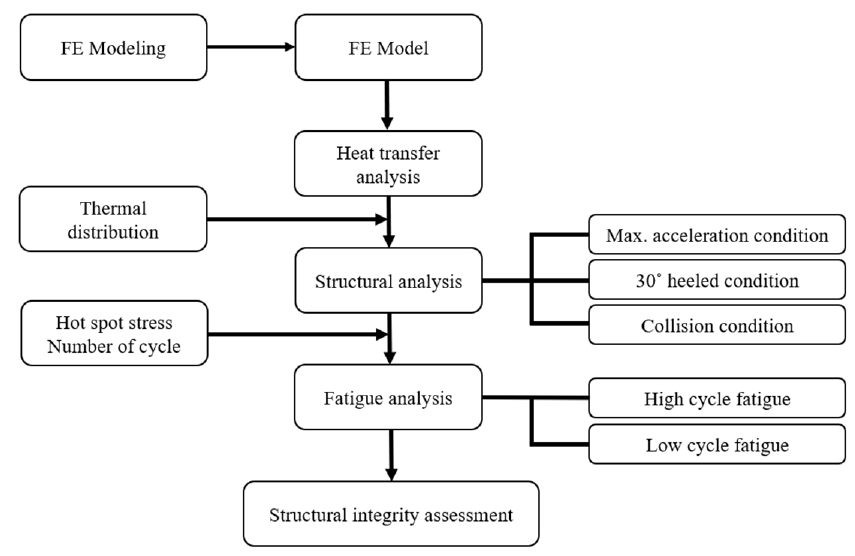
Figure 1. Flow chart of structural integrity assessment for independent type-C cylindrical tank applied in this study.